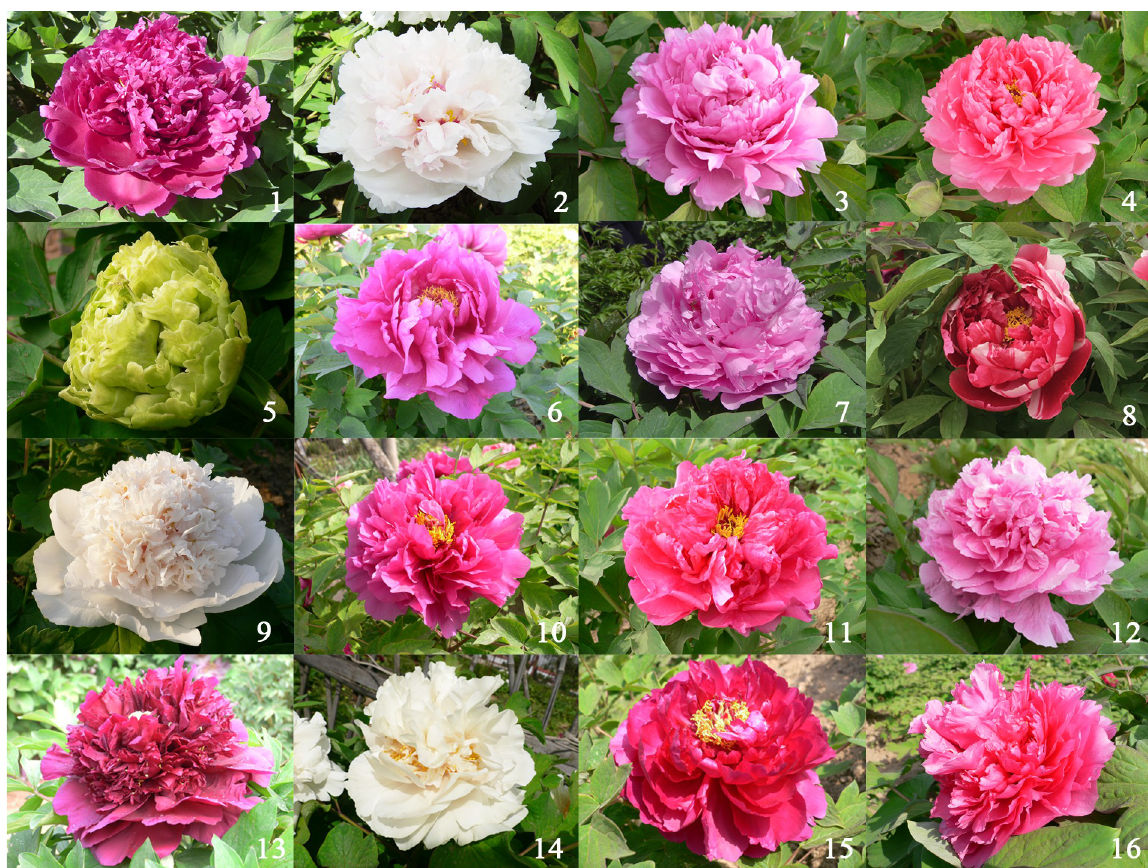
Fig 1. The flowers of 16 peony materials. 1-YLBZ, 2-JY, 3-SBH, 4-FGMT, 5-DL, 6-MJH, 7-SGJ, 8-EQ, 9-QXB, 10-LYH, 11-HBS, 12-CH, 13-YLZZP, 14-YH, 15-WLYH,